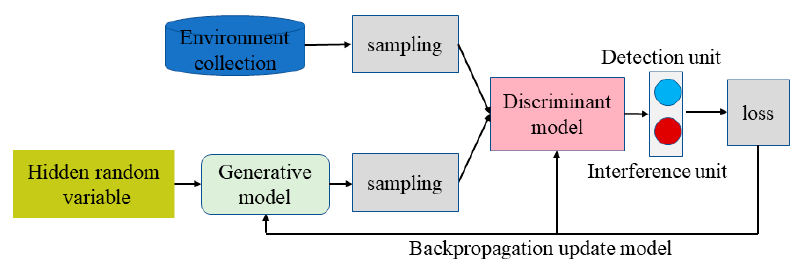
Figure 2. Framework of the generative adversarial network. Optimized discriminant model D.